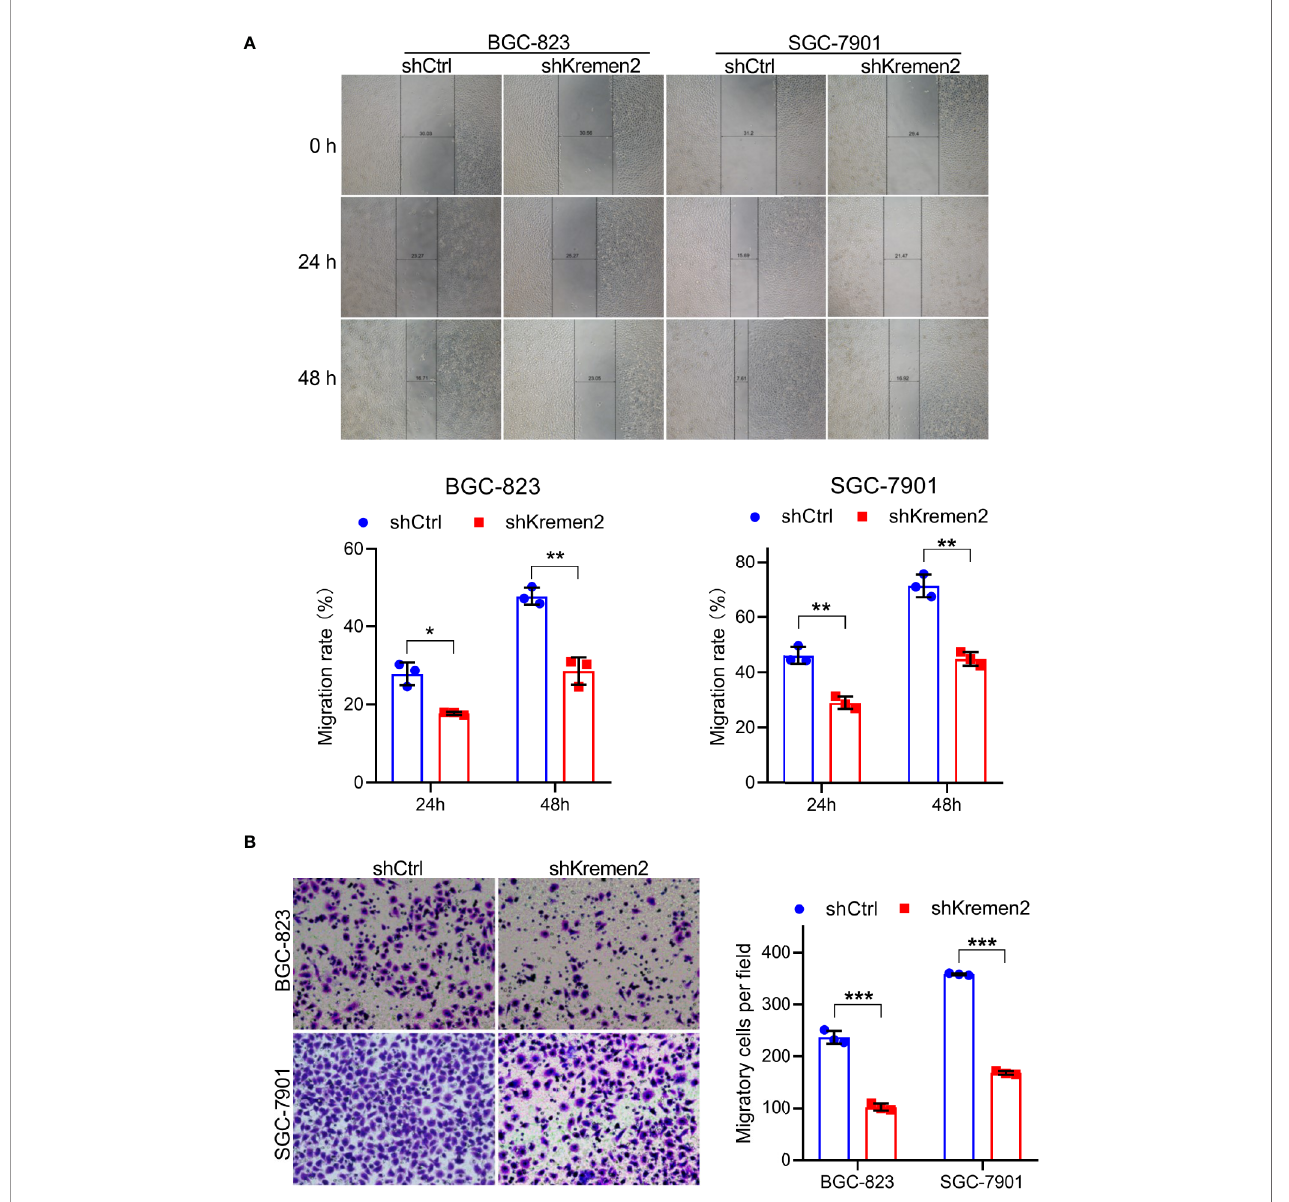
FIGURE 4 | Kremen2 knockdown inhibited migration of GC cells. (A) Kremen2 knockdown blocked wound healing of GC cells. The width was measured at 0, 24, and 48 h after scratching. (B) Kremen2 knockdown inhibited migration of GC cells. Transfected GC cells were cultured in Transwell insert chamber, 24 h later, the cells in the lower chamber were fi xed, stained with hematoxylin. * P < 0.05; ** P < 0.01; *** P <